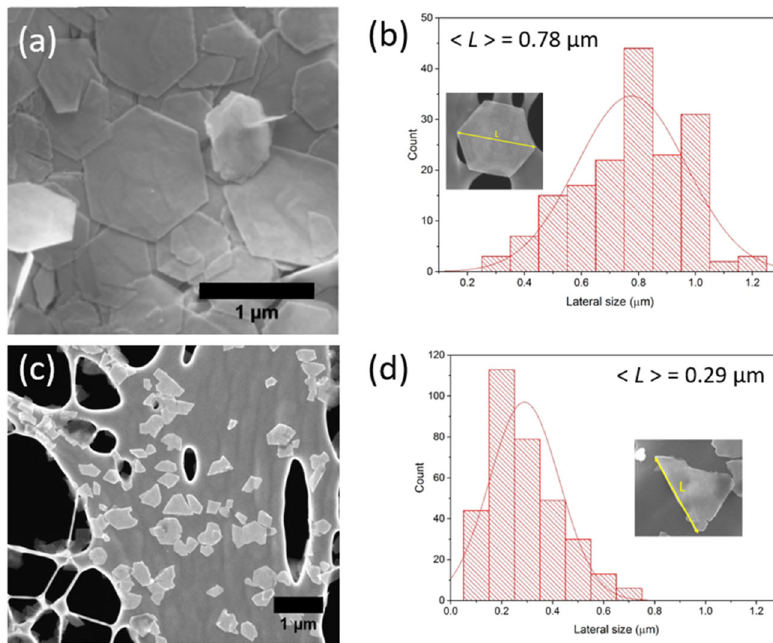
Fig. 2 Demonstration of platelet size reduction upon sonication treatment. a and c SEM micrographs of as-produced and size-reduced platelets respectively and b and d associated platelet size distributions indicating mean platelet size. (Inset ( b and d ) indicate the method of measuring lateral platelets size L). Scale bars are 1 μ m in ( a and c